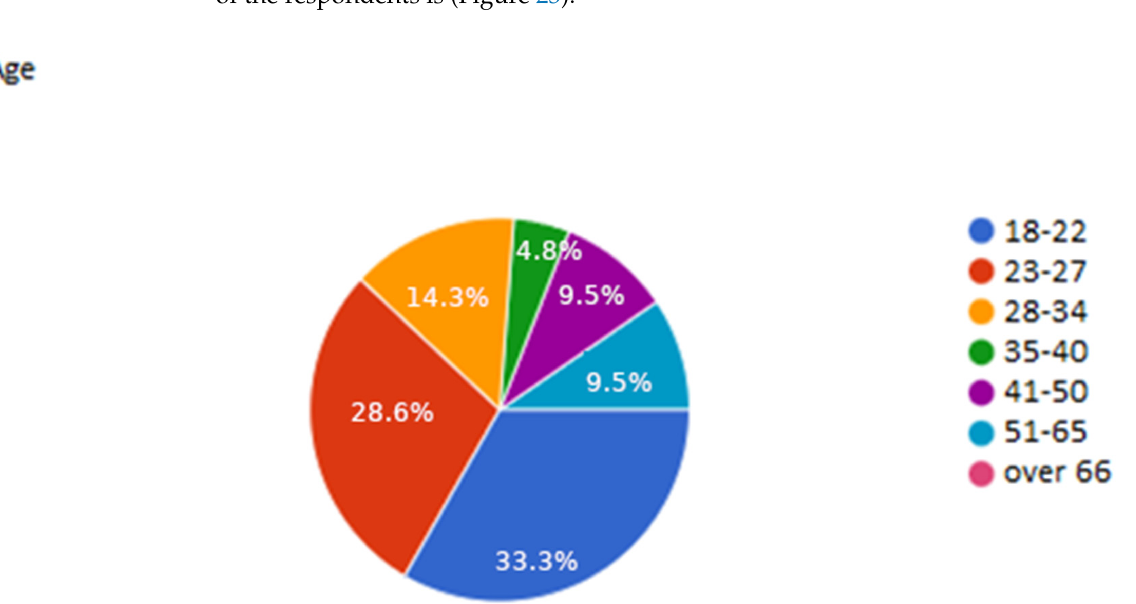
Figure 23. Age of respondents.